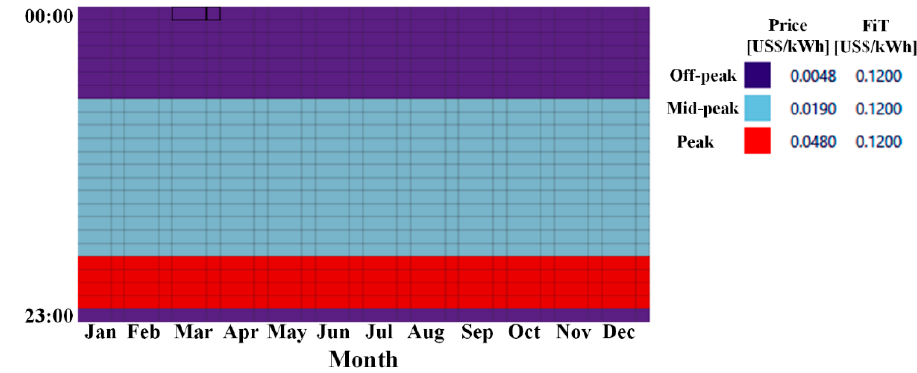
Figure 6. TOU pricing implemented on Iran’s national grid.